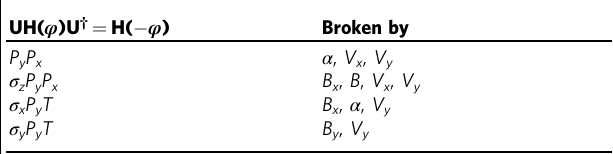
The symmetry operations on the left column are broken by one of the parameters on the right column. These parameters include the in-plane magnetic fi elds B x , B y , the asymmetric disorder potentials V x , V y and the spin-orbit term α which is the consequence of the structural inversion asymmetry (Rashba). To generate an anomalous phase φ 0 , each symmetry operator, one per line of the table, must be broken. For example, the combination of the magnetic fi eld B y and the spin-orbit coupling α is enough to break all